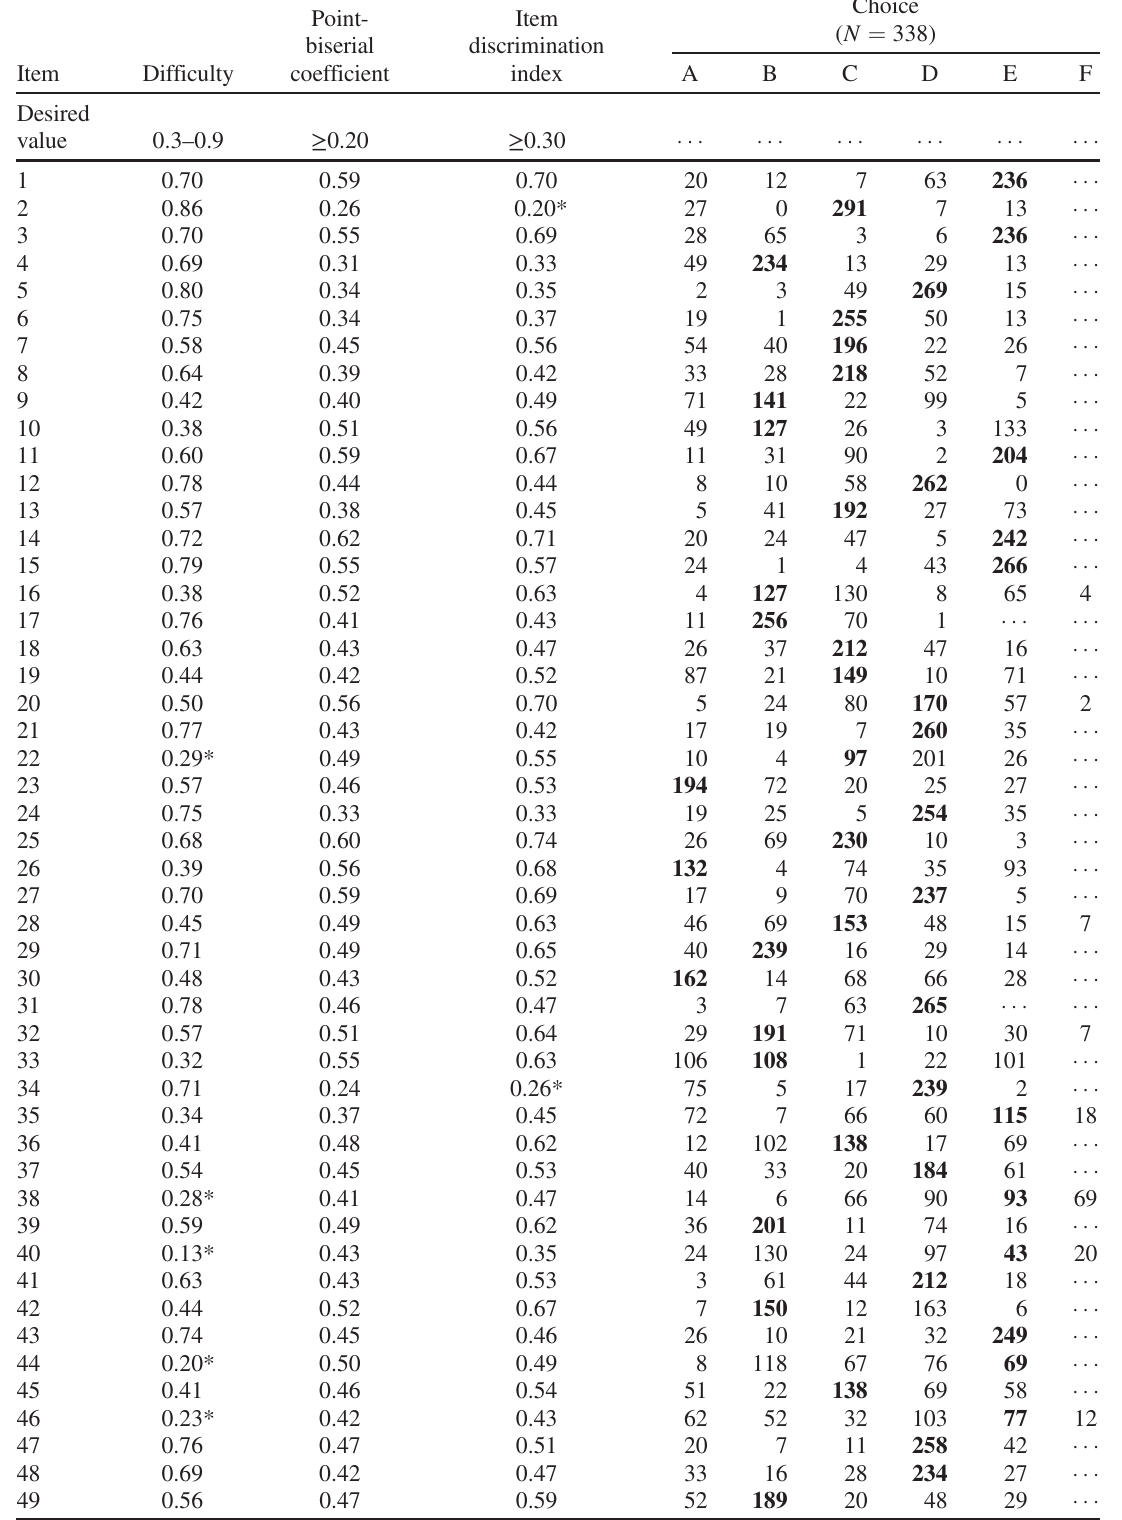
TABLE V. Statistics for the individual items, taken from a sample of 338 postinstruction Gymnasium students. Values marked with a star are not within the desired range. Values in bold typeface indicate the correct